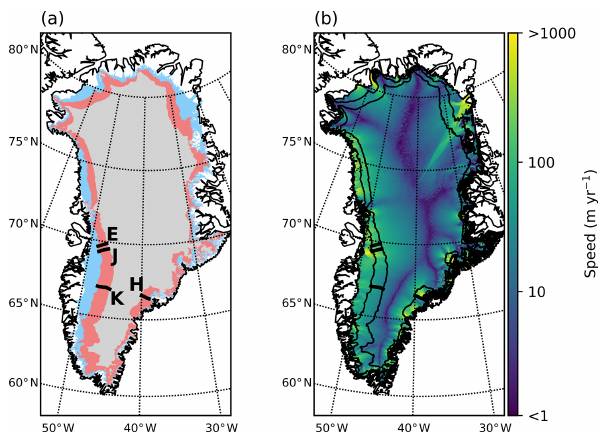
Figure 1. Maps of Greenland. (a) Facies delineated based on mod- eled 1980–2016 average surface melt (Noël et al., 2018): ablation zone (blue) with melt exceeding accumulation; percolation zone (red), the upper limit of which defined by melt conditions at Craw- ford Point, where infiltration has not warmed firn (Humphrey et al., 2012); dry zone (gray). (b) Velocity field from Joughin et al. (2010) with top and bottom of percolation zone shown in (a) , delineated by black contour lines. Thick black lines through the percolation zone show study transects, where E is EGIG, J is Jakobshavn, K is K-transect, and H is Helheim (see Table